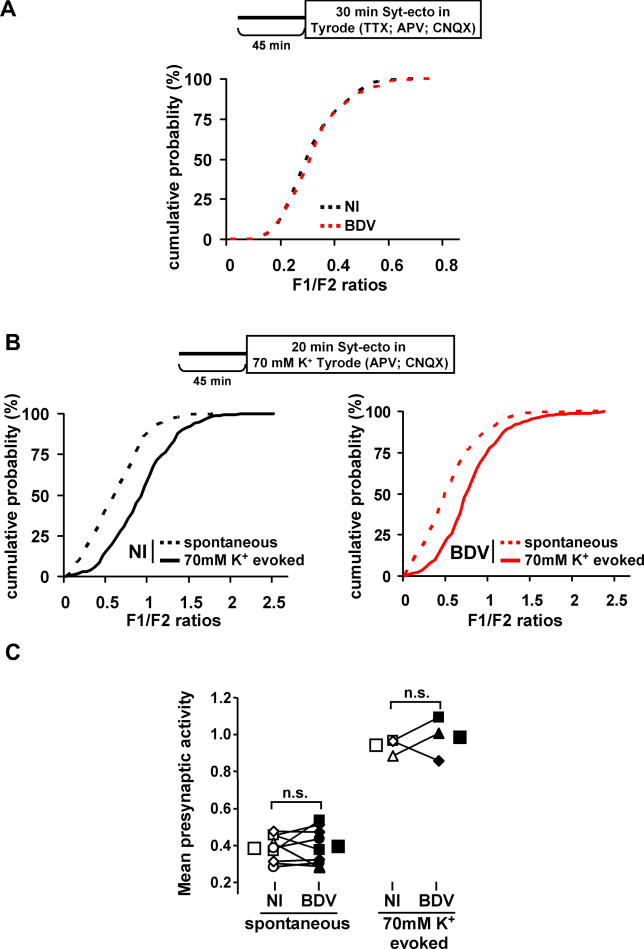
Spontaneous and Evoked SV Recycling Are Not Affected by BDV Infection(A) Cumulative probability distributions of fluorescence ratios (F1/F2) for individual synapses for spontaneous SV recycling. No difference is observed between control (NI) and BDV-infected neurons (p = 0.112, KS test).(B) Cumulative probability distributions of fluorescence ratios (F1/F2) for individual synapses for 70 mM K+ evoked and spontaneous SV recycling. In both NI and BDV-infected neurons, the level of SV recycling is significantly increased in neurons stimulated with 70 mM K+ (p < 0.001, KS test). The overview of the experimental stimulation protocol is depicted above each graph.(C) Pairwise comparisons of mean presynaptic activities in independent experiments involving at least 300 synapses (small symbols). Bigger squares correspond to mean values of all independent experiments. n.s., not significant using paired t test.